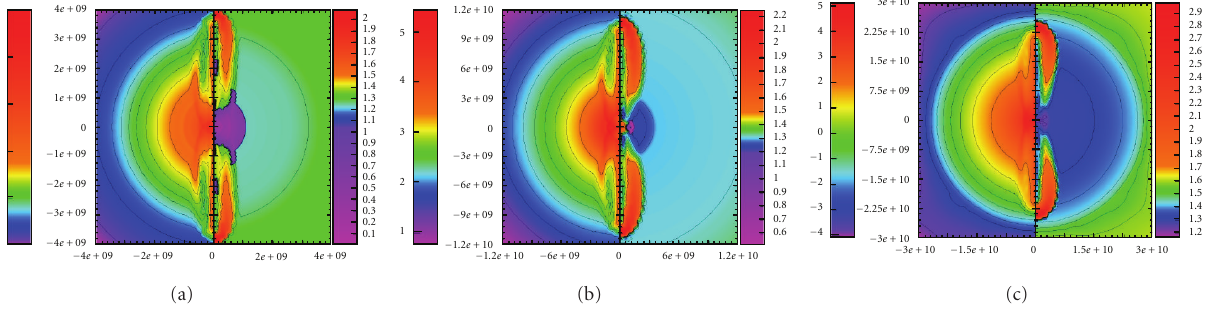
Figure 25: Snapshots showing MHD explosions of CCSNe at 0.8, 2.0, and 4.3sec after core bounce from left to right (e.g., [268]). In each figure, contour of the logarithmic density (g / cm 3 ) (left) and entropy per baryon ( k B ) (right) are shown. The unit of the horizontal and the vertical axis is in (cm). Note that the di ff erence of the length scale for each panel and that the outermost radius of the progenitor is ∼ 3 × 10 10